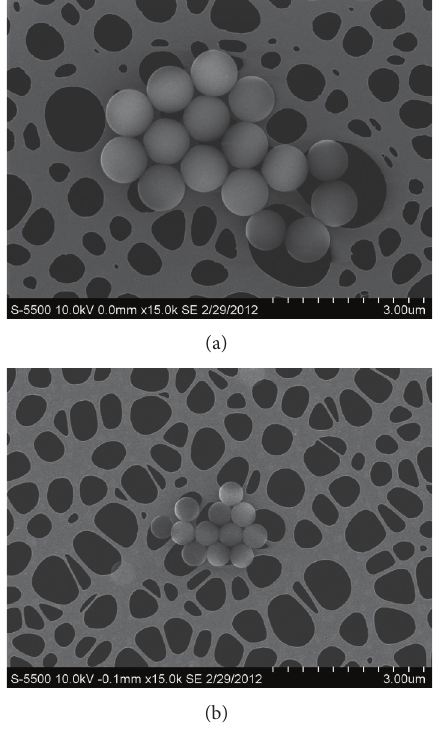
Sample C: TEOS solution added (5 times, 4 mL each time) into a 96% EtOH/PS solution; Sample D: TEOS solution added (100 times, 0.2 mL each time) into a 96% EtOH/PS solution.